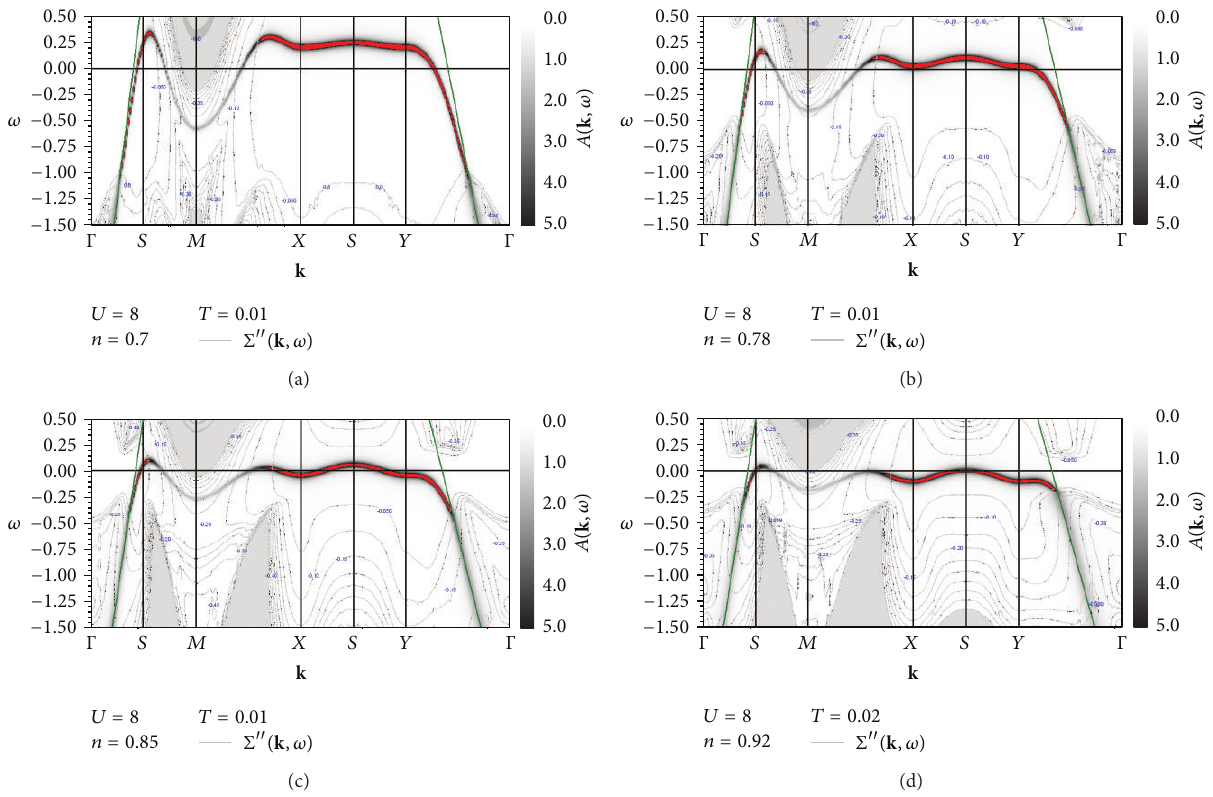
Figure 3: (Color online) Spectral function 𝐴( k , 𝜔) close to the chemical potential ( 𝜔 = 0 ) along the principal directions ( Γ = (0,0) → 𝑀 = (𝜋,𝜋) , 𝑀 → 𝑋 = (𝜋,0) , 𝑋 → 𝑌 = (0, 𝜋) and 𝑌 → Γ ) for 𝑈 = 8 , 𝑇 = 0.01 and (a) 𝑛 = 0.70 , (b) 𝑛 = 0.78 , (c) 𝑛 = 0.85 , and (d) 𝑛 = 0.92 ( 𝑇 = 0.02